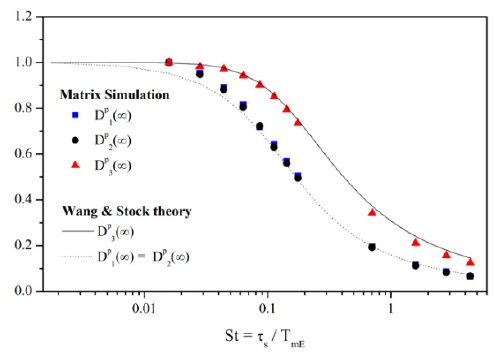
Figure 25. Particle dispersion coefficients (g ≠ 0).